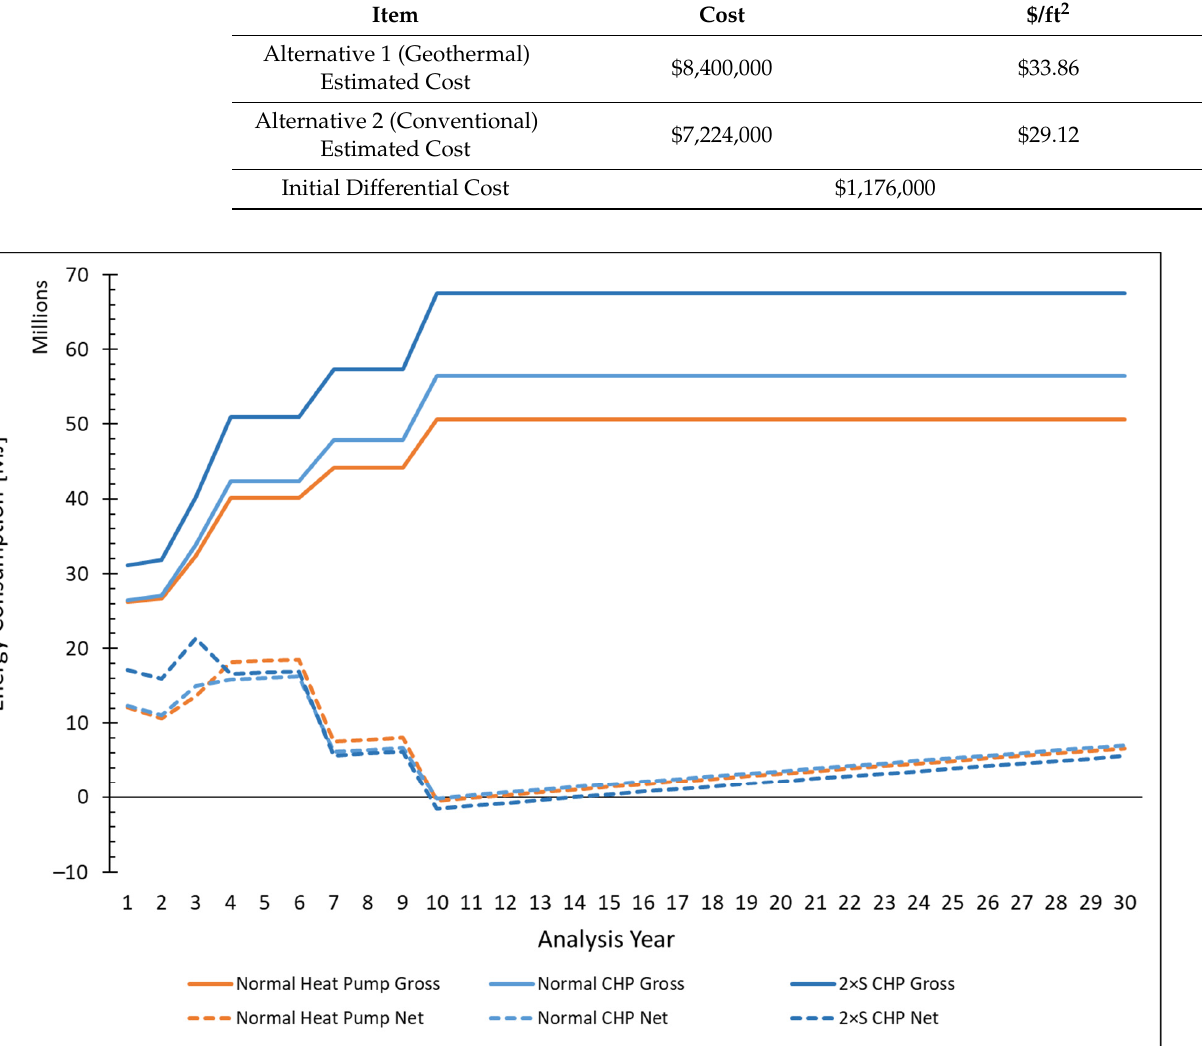
Figure A3. NWC annual gross and net energy load over 30-year economic analysis period. Five phases of building construction are considered, such that year 10 is the first year reflecting full build-out. Gradual increase in net load over time is reflective of assumed 0.75% degradation in annual PV generation.